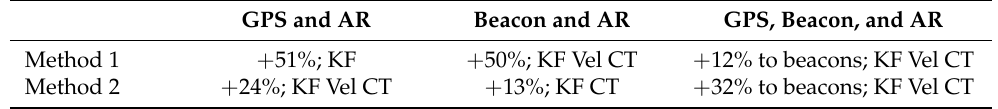
Table 15. MSE improvement of KF Vel CT. GPS and AR Beacon and AR GPS, Beacon, and